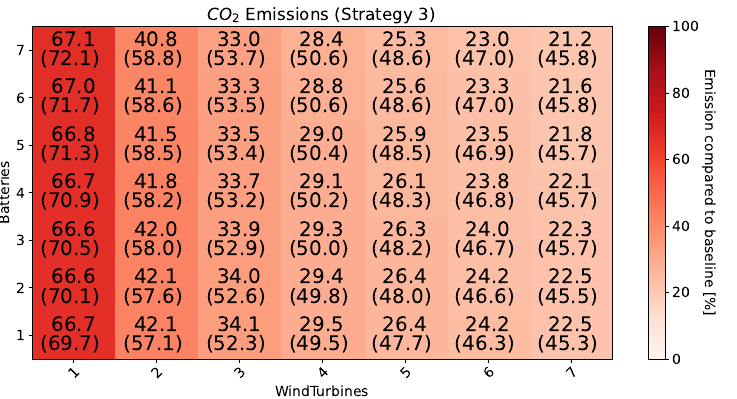
Figure 21. CO 2 emissions relative to baseline when the gas turbines can be turned off completely (0 emissions) or are kept idle with an emission rate of 0.5 kgs − 1 , shown in parentheses.